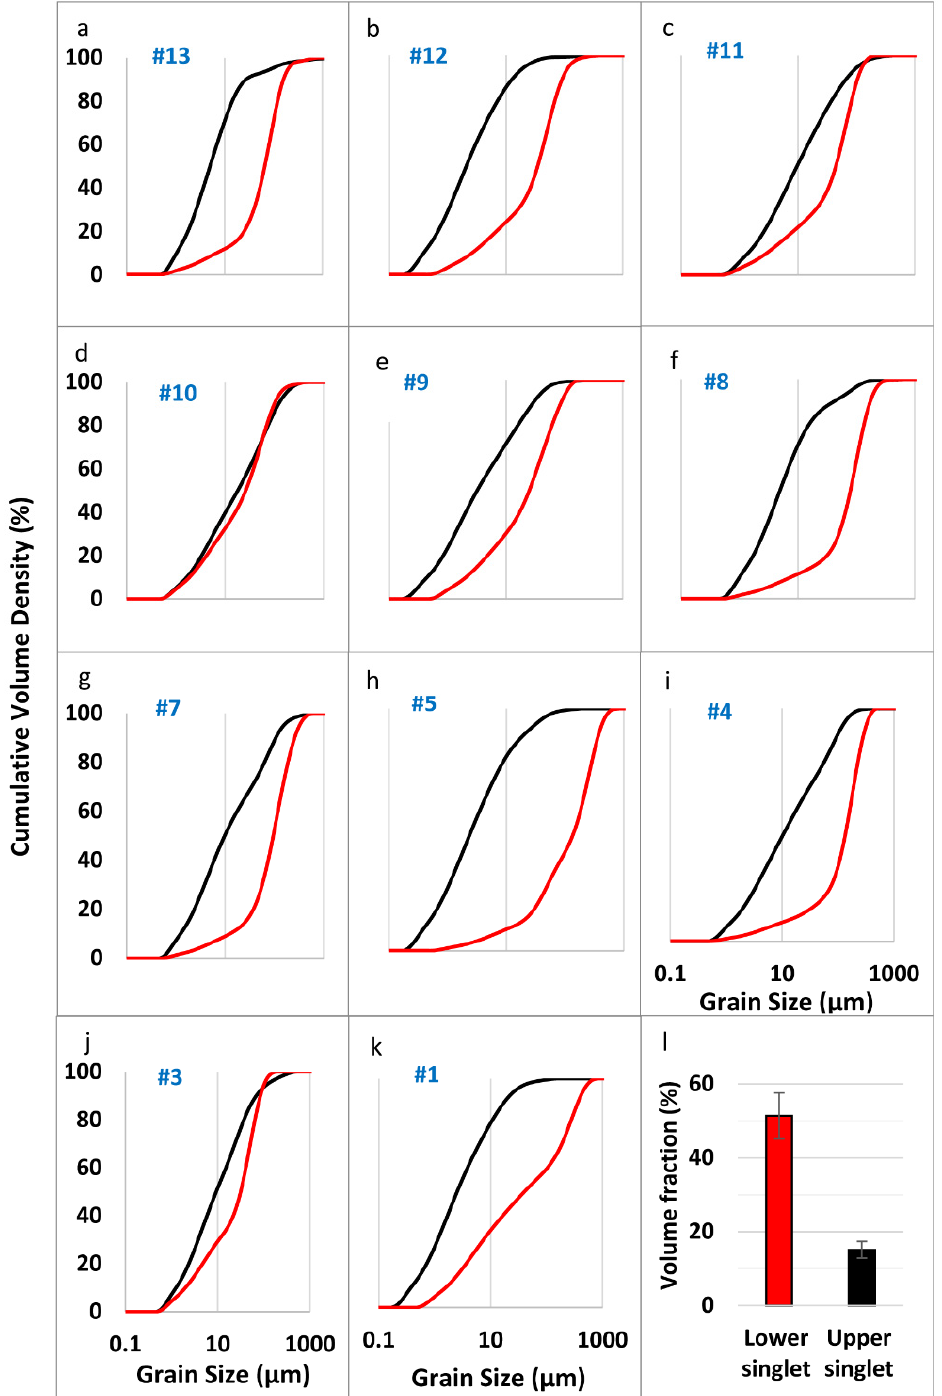
Figure 4. Cumulative frequency distributions of grain size (presented as cumulative volume density) of the upper finer-grained singlet (black line) and the coarser silt and sand lower singlet (red line) of 11 event layers sampled in pit 3 ( a – k ; layer #1 is oldest). The volumetric fraction of sand (50–2000 µm) is significantly smaller ( p -value < 0.01) in the upper singlet compared to that in the lower singlet ( l ).